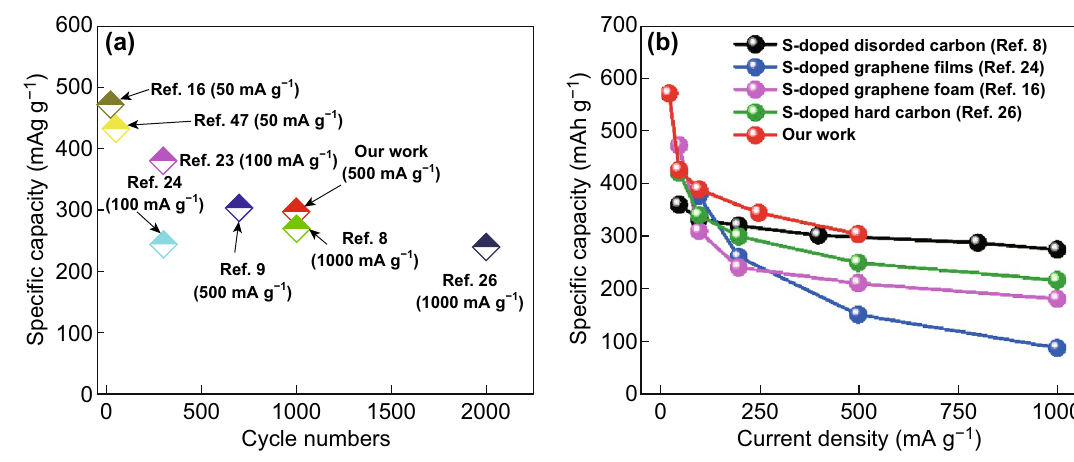
Fig. 4 a Long-term cycling performance and b rate performance of other S-doped C-based materials for comparison